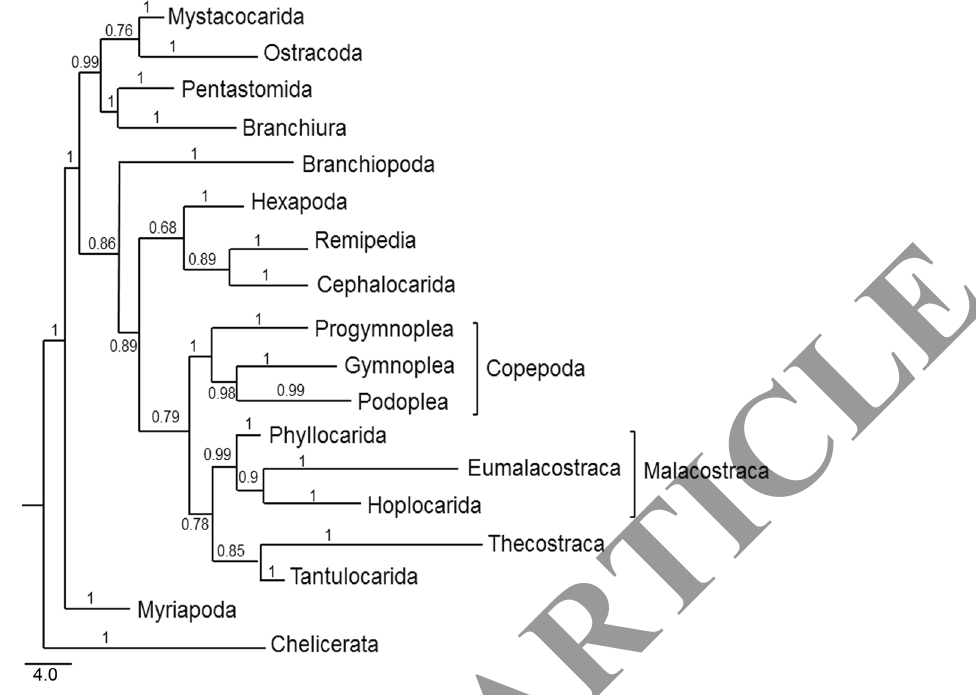
Figure 1. Phylogenetic relationship of Pancrustacea. Phylogenetic relationship of 510 species of Pancrustacea (collapsed to major taxa level) based on 18S rRNA sequences. Numbers show the posterior probabilities calculated by Bayesian